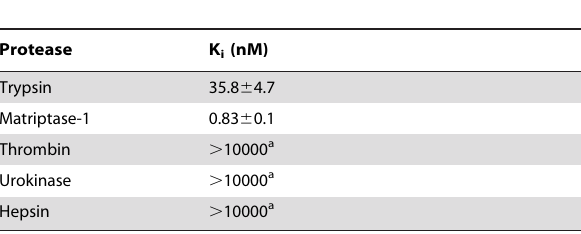
Table 2. Selectivity profile of MCoTI-based inhibitor Var.